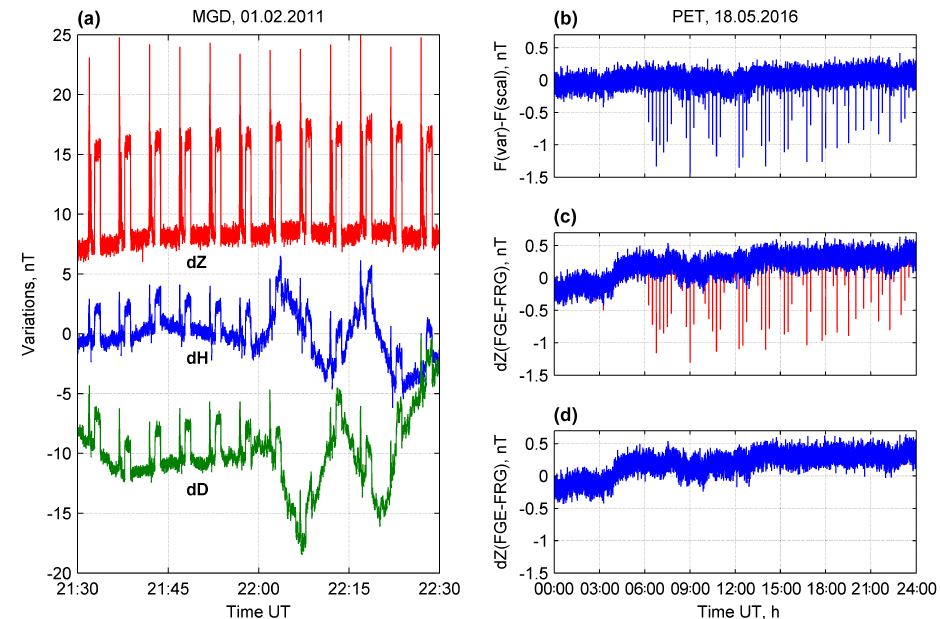
Figure 2. Example of regular noise in magnetic data arising during ionosonde operation. (a) At the Magadan observatory the ionosonde operates with a 5min periodicity and makes noise signals in all components, recorded by FGE fluxgate magnetometer. (b, c, d) At the Paratunka observatory the ionosonde operates with 15min periodicity. The effects appear in all records of fluxgate variometer FGE, mainly in the vertical component Z . These spikes are visible in the differences between total intensity F (var), calculated from FGE data, and F (scal) calculated from scalar magnetometer GSM-90 (b) . Subplot (c) shows the differences between Z records of FGE (with noise from ionosonde) and Japanese fluxgate magnetometer FRG-601, which is not affected by ionosonde activity. Subplot (d) shows the result of clearing the ionosonde effects from FGE